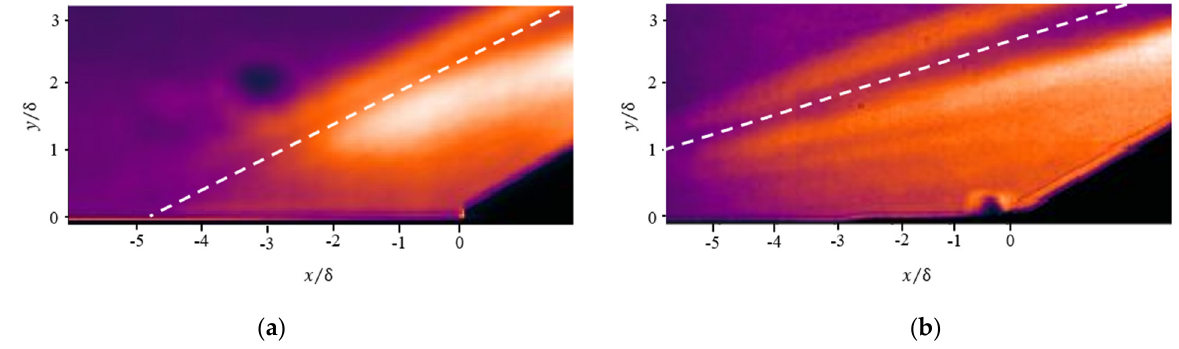
Figure 6. RMS fields for SWBLI, ( a ) smooth surface, and ( b ) rough surface. The white dashed lines indicate the mean shock position for each case.